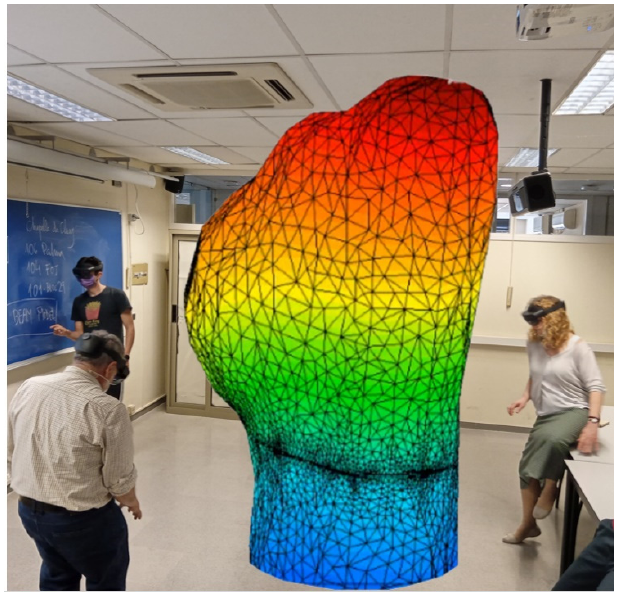
Figure 23. “Cadireta” (Montserrat): visualization concept of FEM results in MR. The elements are colored according to the value of the displacement, ranging from blue (zero) to red (close to 12 mm).